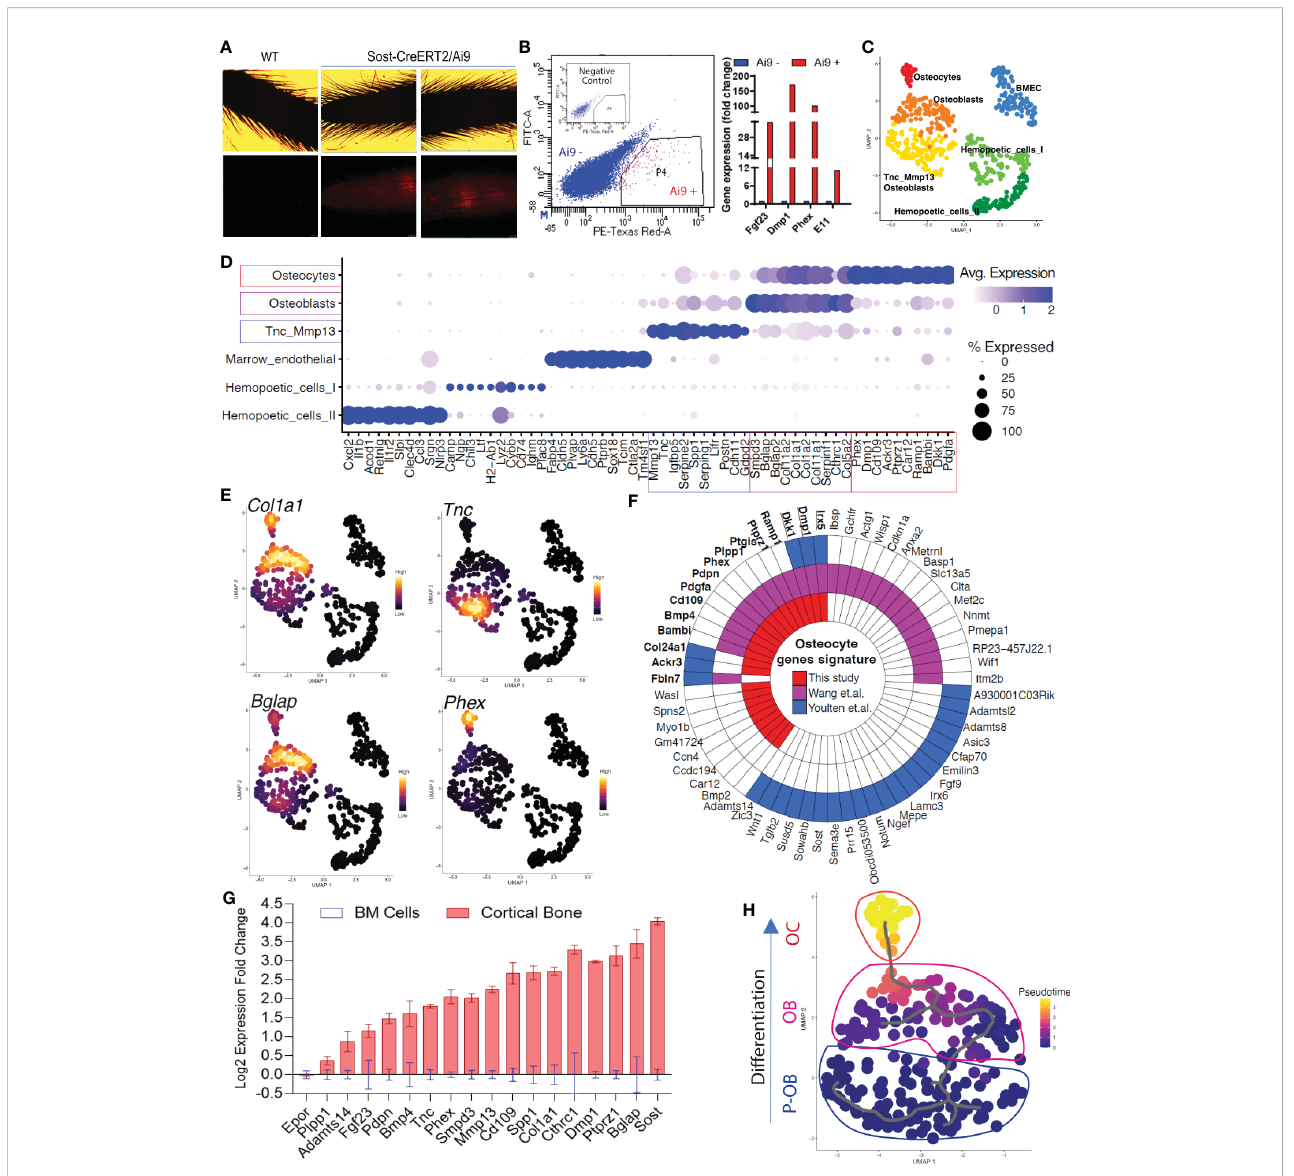
FIGURE 1 Single-cell transcriptomic pro fi ling of bone cells identi fi ed osteolineage heterogeneity. (A, B) . Long bones (femur, tibia, and humeri) were subjected to serial collagenase/EDTA digestions (see Methods), and cells from fractions 4-9 were collected for FACS sorting to isolate tdTomato-positive cells, followed by single-cell RNAseq library construction. Analysis by qPCR con fi rmed high mRNA expression of osteocyte genes Fgf23 , Dmp1 , Phex , and Pdpn in Ai9 positive cells versus Ai9 negative cells. (C) . Bioinformatic analysis was performed to cluster the cells by UMAP. Each dot represents a single cell, and cells sharing the same color code indicate discrete populations of transcriptionally similar cells. (D) . De fi ning cortical bone cell types. Tnc/ Mmp13 osteoblast cells were distinctly marked by Tnc and Mmp13 . Osteoblast cells showed high expression of Smpd3 and Bglap . Osteocytes had the highest expression of Dmp1 and Phex . (E) . Expression density plots indicated cells with high transcription of Col1a1 , Tnc , Bglap , and Phex . (F) . The polar fi gure highlights the osteocyte markers isolated from our dataset (long bone cell scRNAseq), Wang et al. (long bone and calvaria cell scRNAseq (10);) and Youlten et al. (long bone bulk RNAseq (9);). (G) . Canonical and non-canonical osteolineage genes were validated as being highly expressed in cortical bone when compared to the expression detected in bone marrow. (H) . Pseudotime analysis revealed Tnc/Mmp13 Osteoblasts as an osteoblast precursor cell (P-OB), and shows their differentiation to osteoblasts (OB) and then osteocytes